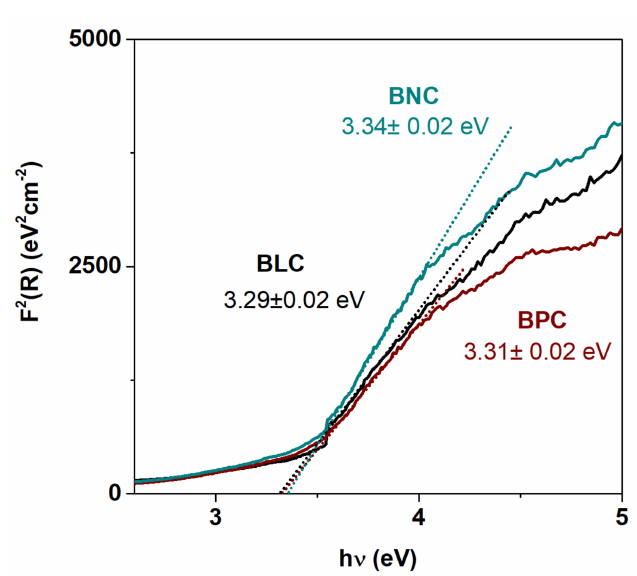
Figure 12. Plot of Kubelka–Munk function vs. energy for all measured compositions as well as values of energy gap at RT for BLC, BPC, and